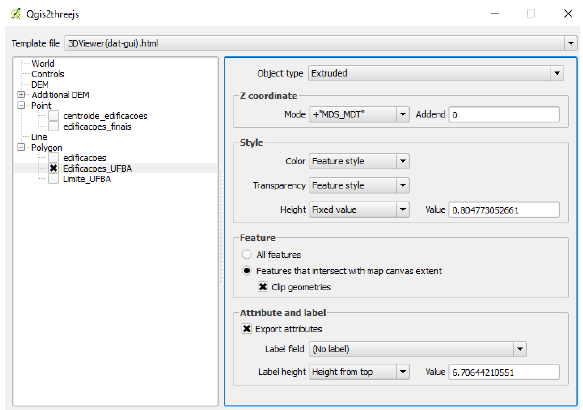
Figure 7: Extrusion of the buildings from the corresponding Z coordinate